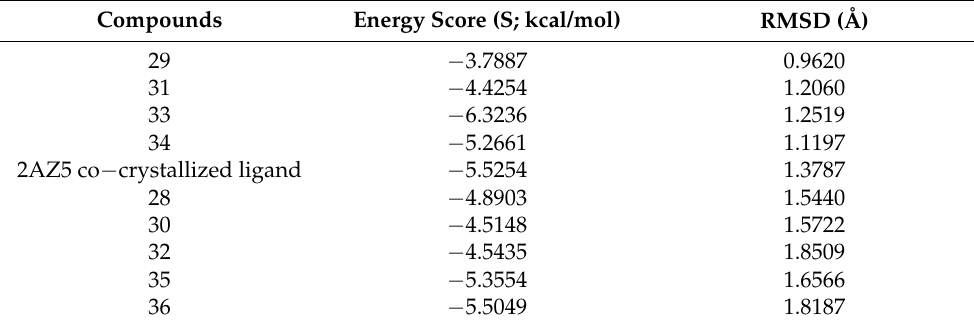
Table 3. Interaction binding energies (S; kcal/mol) and binding accuracy (RMSD; Å) of isolated compounds from V. vinifera seeds and co-crystallized ligand within TNF- α active site (PDB ID: 2AZ5). Compounds Energy Score (S; kcal/mol)